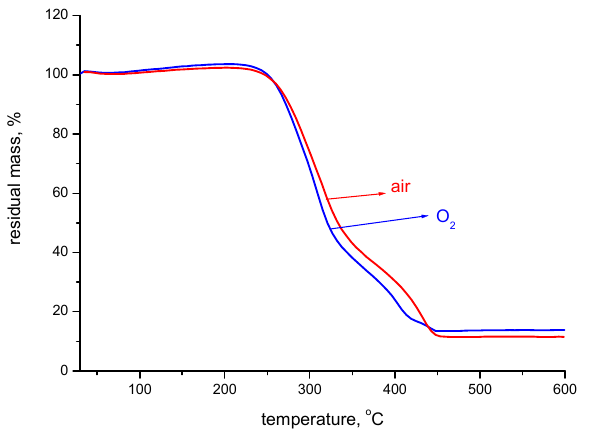
Figure 2. The average non-isothermal thermogravimetry–temperature runs (from 2 parallel exper- iments) in oxygen, and air for Cumaru wood at the rate of heating 10 °C/min.